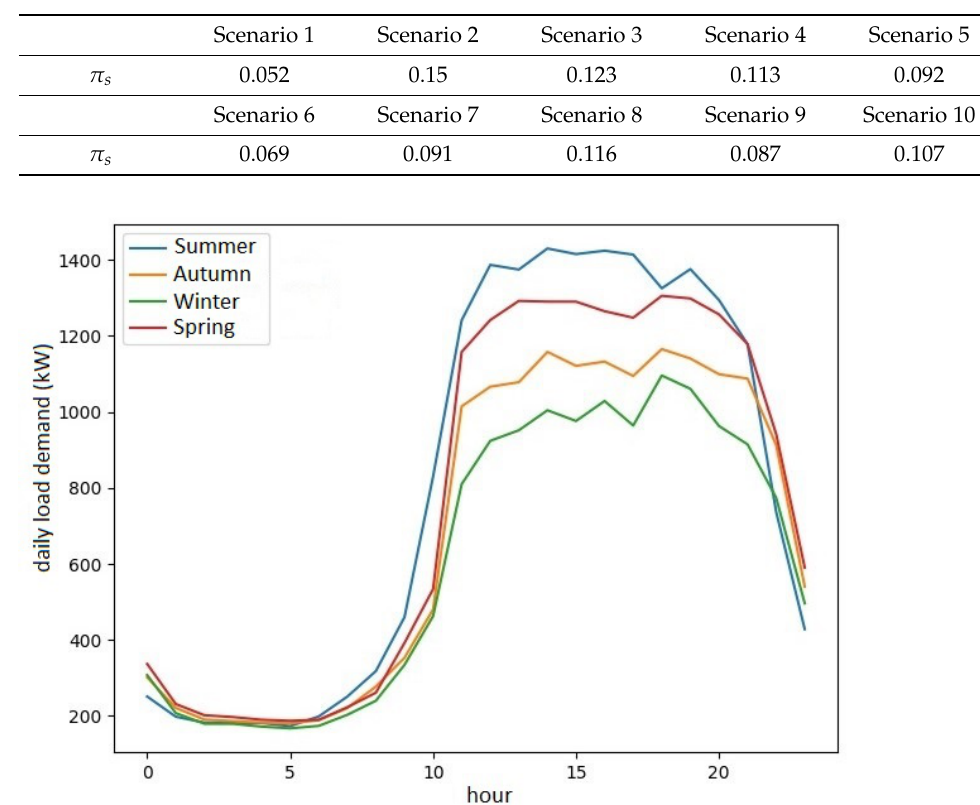
Figure 1. Optimization metric (SSE) in terms of the number of clusters. Table 1. Probability occurrence of scenarios.